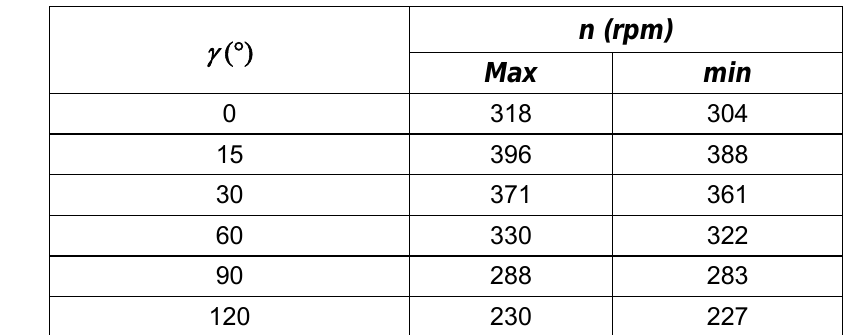
Table 1 – Rotor RPM measured at different vertical angles of the wind